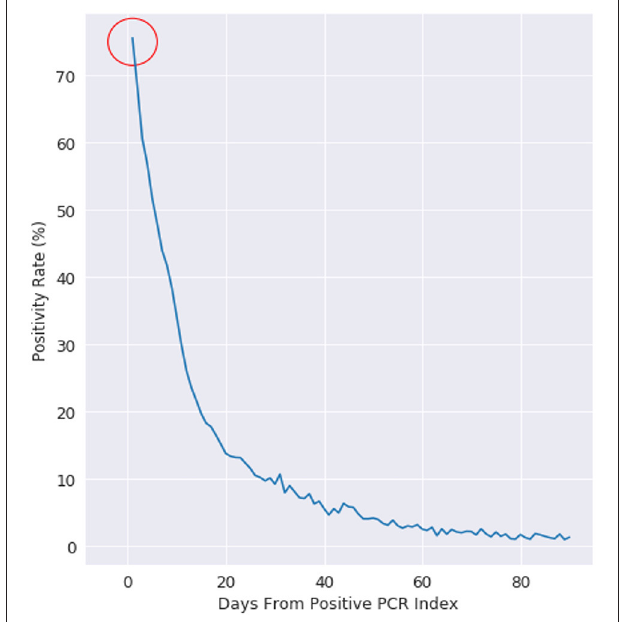
FIGURE 1 | Positivity rate of PCR positive patients, where day 0 is the day of a patients first positive test. This figure is plotted for all US patients with more than 1 PCR test after a positive PCR